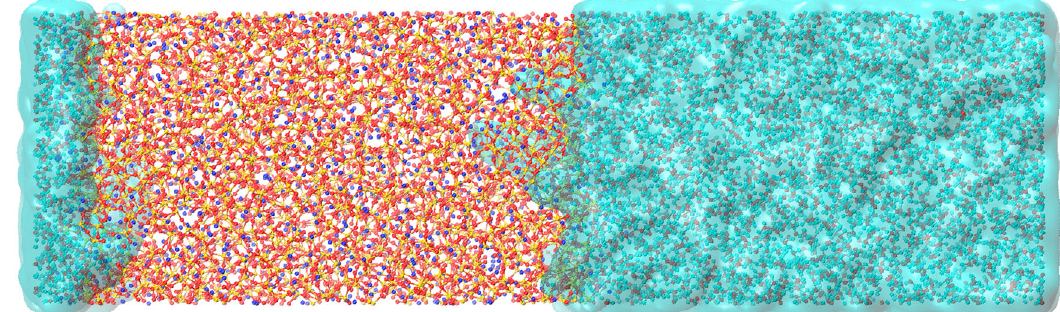
Fig. 13 Snapshot of the sodium silicate glass – water interface after reactions for 3 ns at 450 K. The image shows water penetration after the reactions and pockets of water transport deeper into the glass. The balls in red, orange, purple, and cyan represent for the oxygen, silicon, sodium, and hydrogen atoms, respectively. The surface of area containing hydrogen atoms is also presented as the cyan